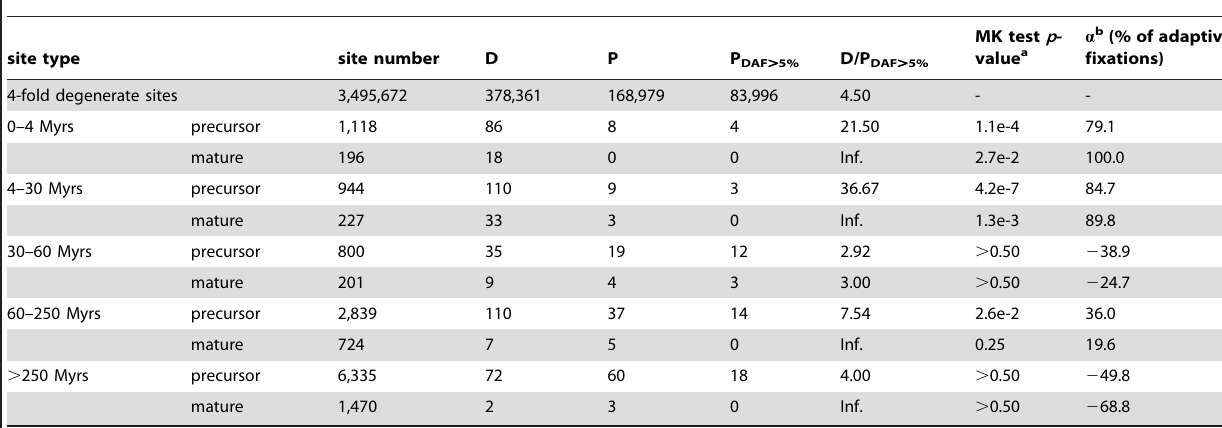
Table 3. The McDonald-Kreitman test on the entire group of miRNAs of the same age.